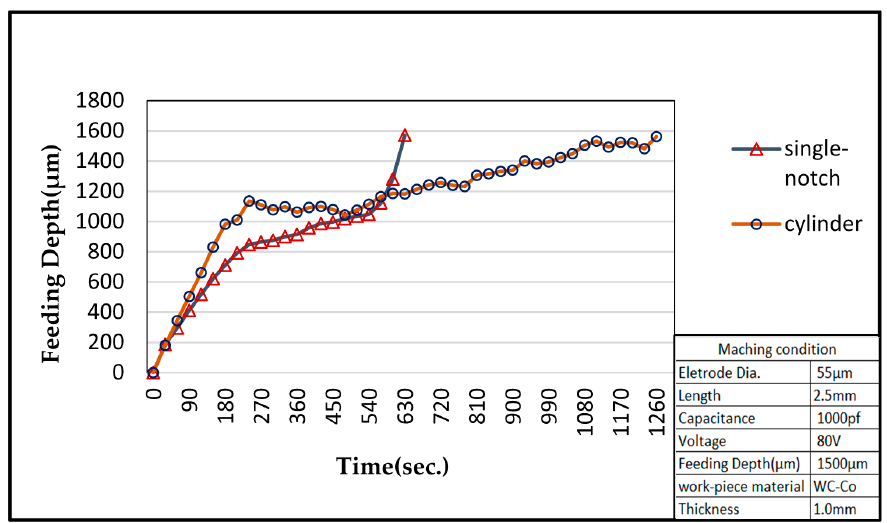
Figure 17. Comparison between the feeding depth of the cylinder tool and cut-side tool.